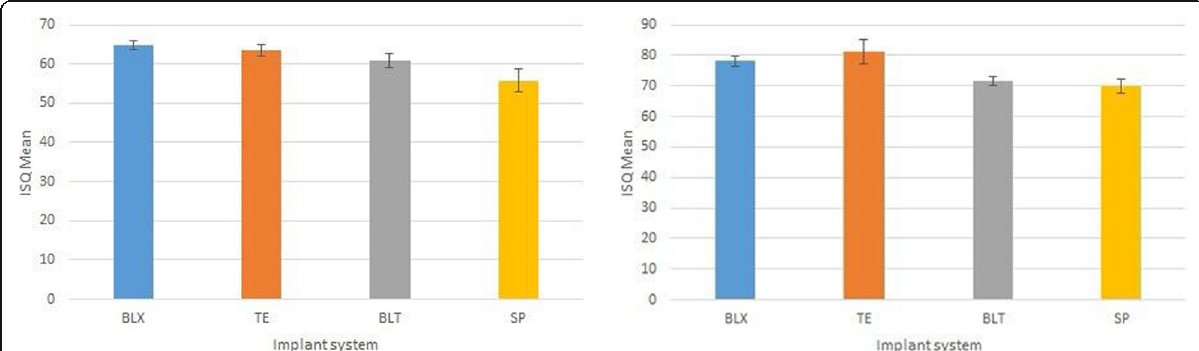
Fig. 4 a BLX implant showed higher ISQ values compared to other groups. The significant difference was found when compared to SP and BLT groups (p 0.001 and p 0.0016, respectively). Besides that, TE implants showed also statistically significant superiority compared to SP (p 0.001). The difference between BLT and SP groups was also remarkable (p 0.003). b TE implants showed slightly higher values compared to BLX; however, the difference was statistically insignificant. BLX and TE implants showed significantly higher ISQ values compared to BLT and SP groups